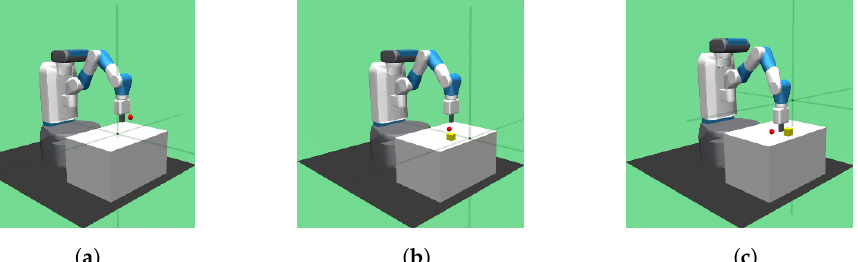
Figure 3. Experimental environments. Agents are trained in OpenAI Gym Fetch simulated envi- ronment, including three robotic manipulation tasks: Reach, Pick-and-Place, and Push. ( a ) Reach; ( b ) Pick-and-Place; ( c )